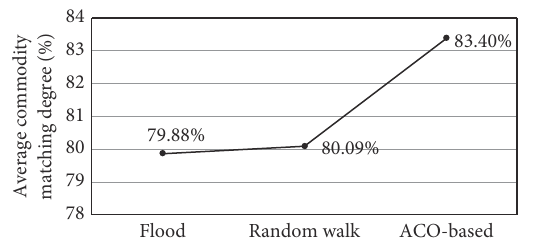
Fig. 3 Average commodity matching degree chart.